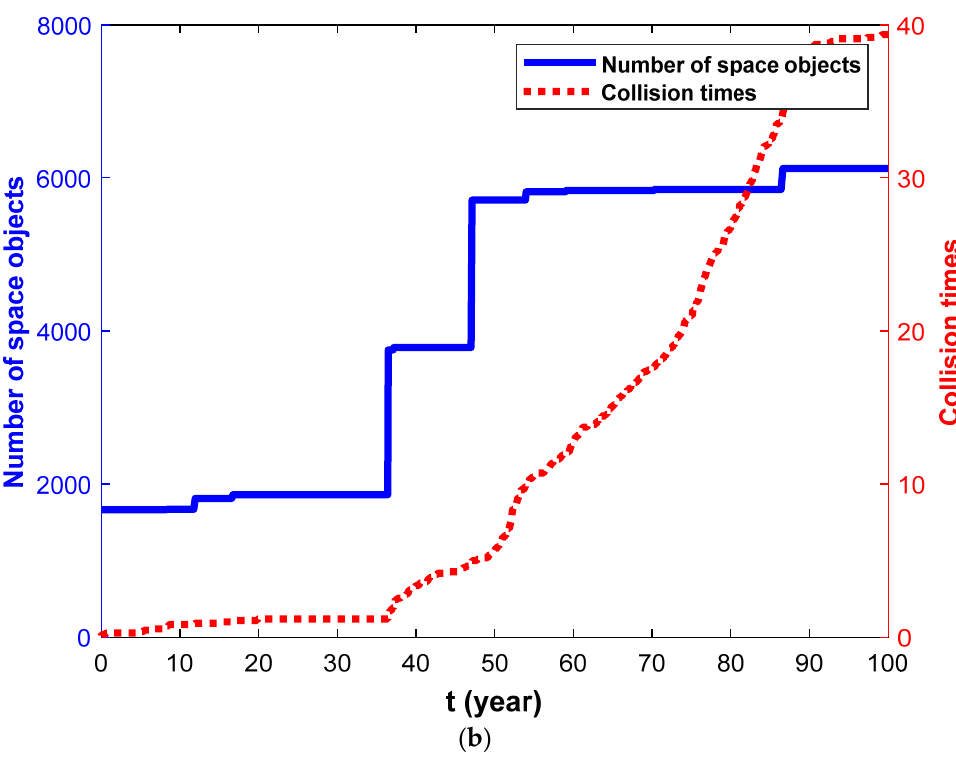
Figure 6. Two simulations of the third scenario: ( a ) simulation with the largest number of space objects after 100 years; ( b ) simulation with the smallest number of space objects after 100 years.